Question: Express in one sentence what the figure is showing.
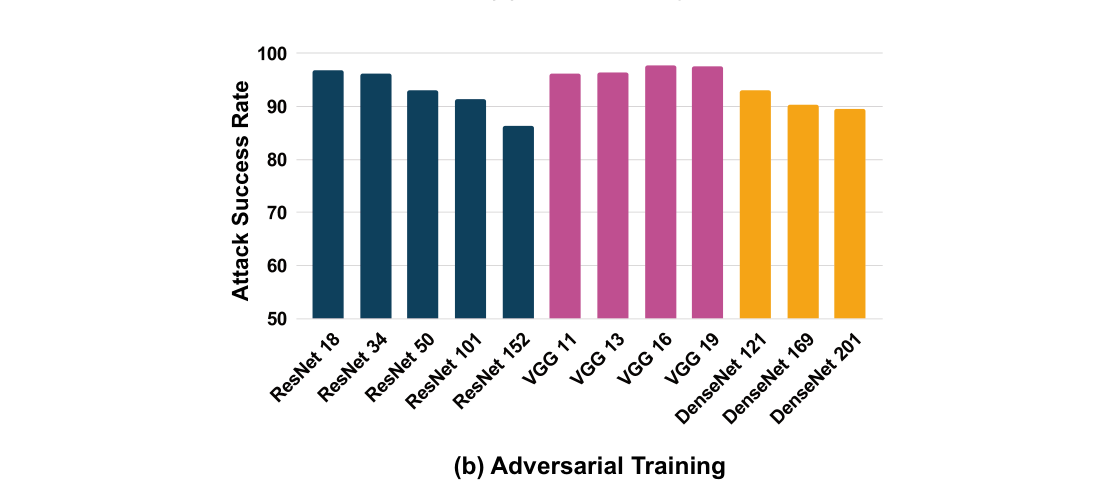
Answer: Bit Squeezing defense and Adversarial Training against SimBA on ImageNet. The model becomes easier to defend as the number of layers on the same model increases